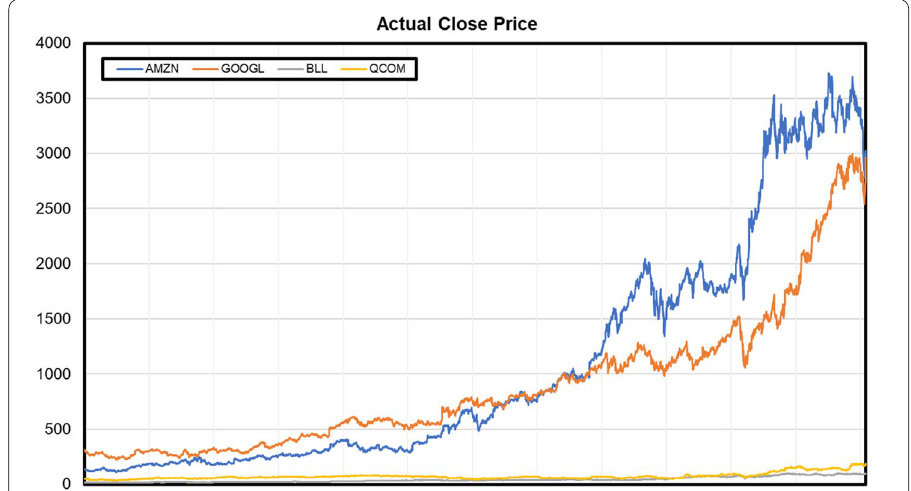
Fig. 8 Visualization of the close price time-series data of the selected four